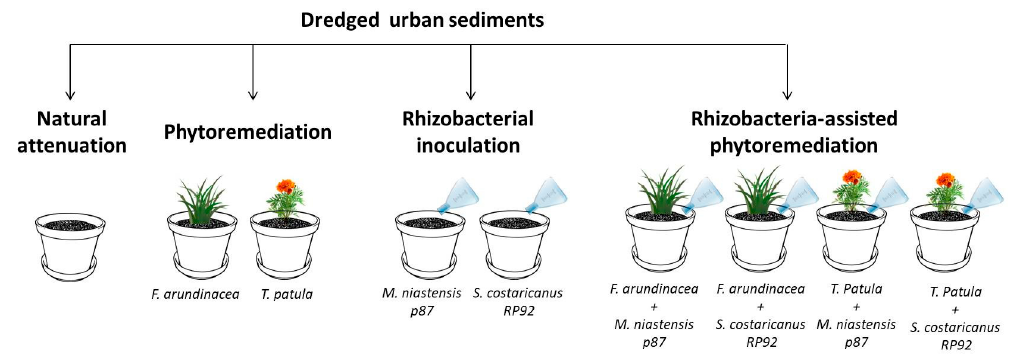
Figure 1. Experiment design.